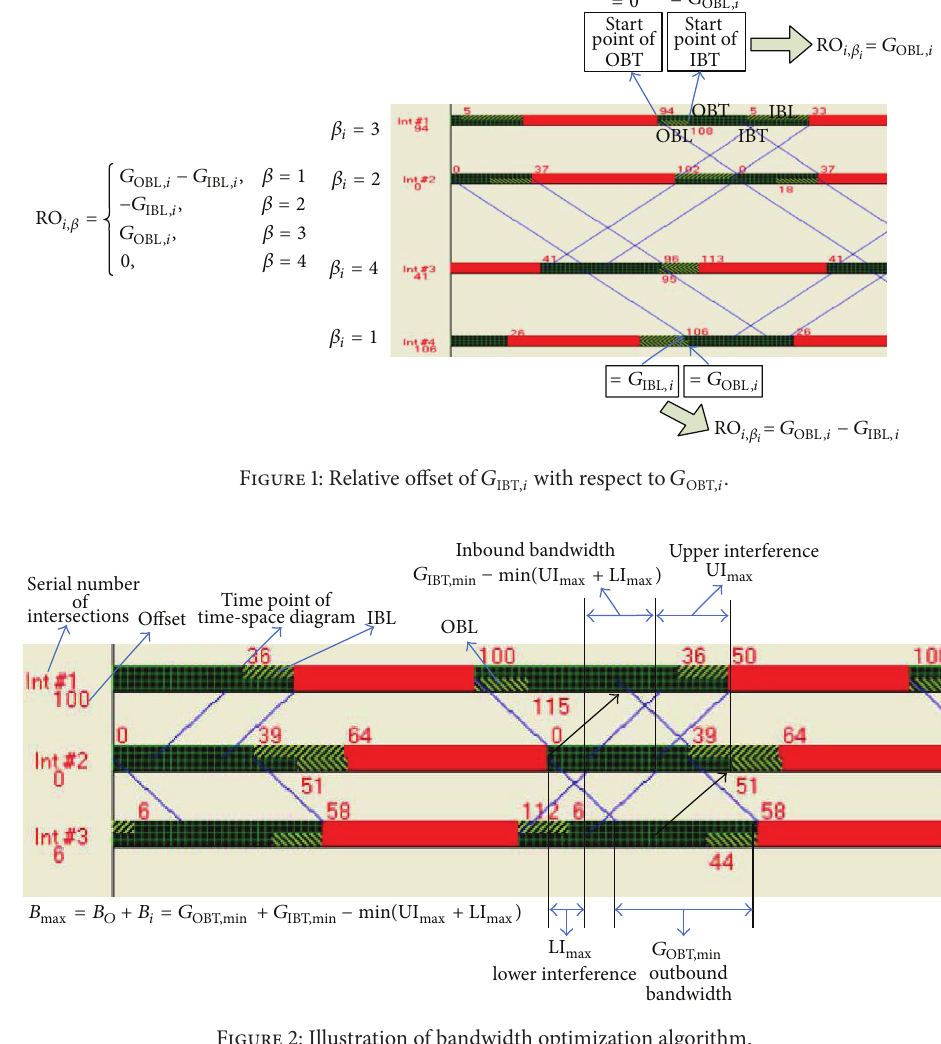
Figure 2: Illustration of bandwidth optimization